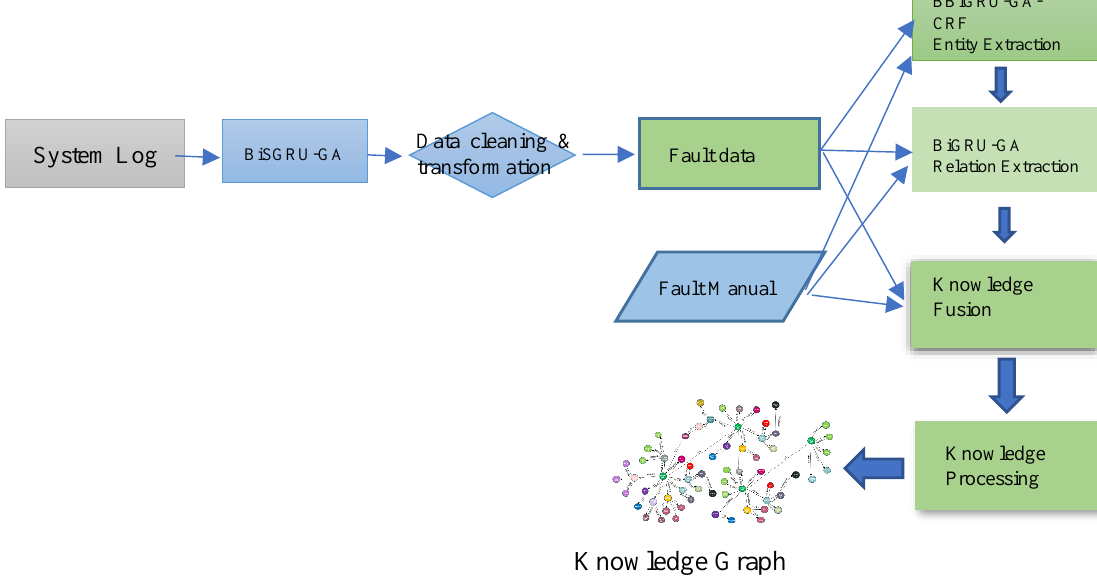
Figure 8. Knowledge graph creation process.